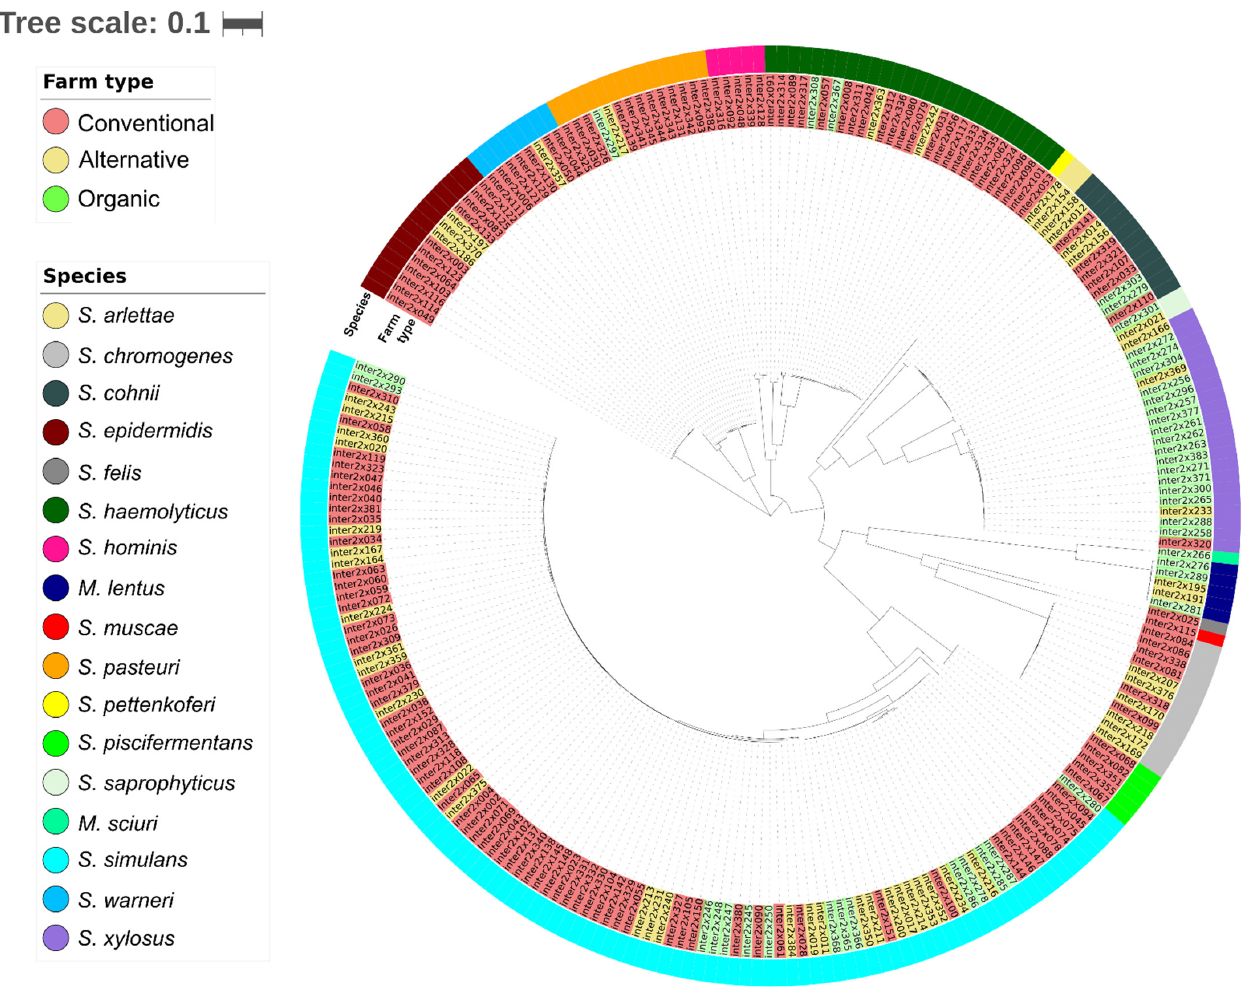
Figure 3. Phylogenetic and population analyses using iTOL: Phylogenetic tree displaying the species distribution among the farm isolates. In the inner ring, the isolates are grouped according to their closeness and are colour-coded representing their farm type; conventional (red), alternative (yellow), and organic (green). The outer ring represents the classification of species for the isolates.